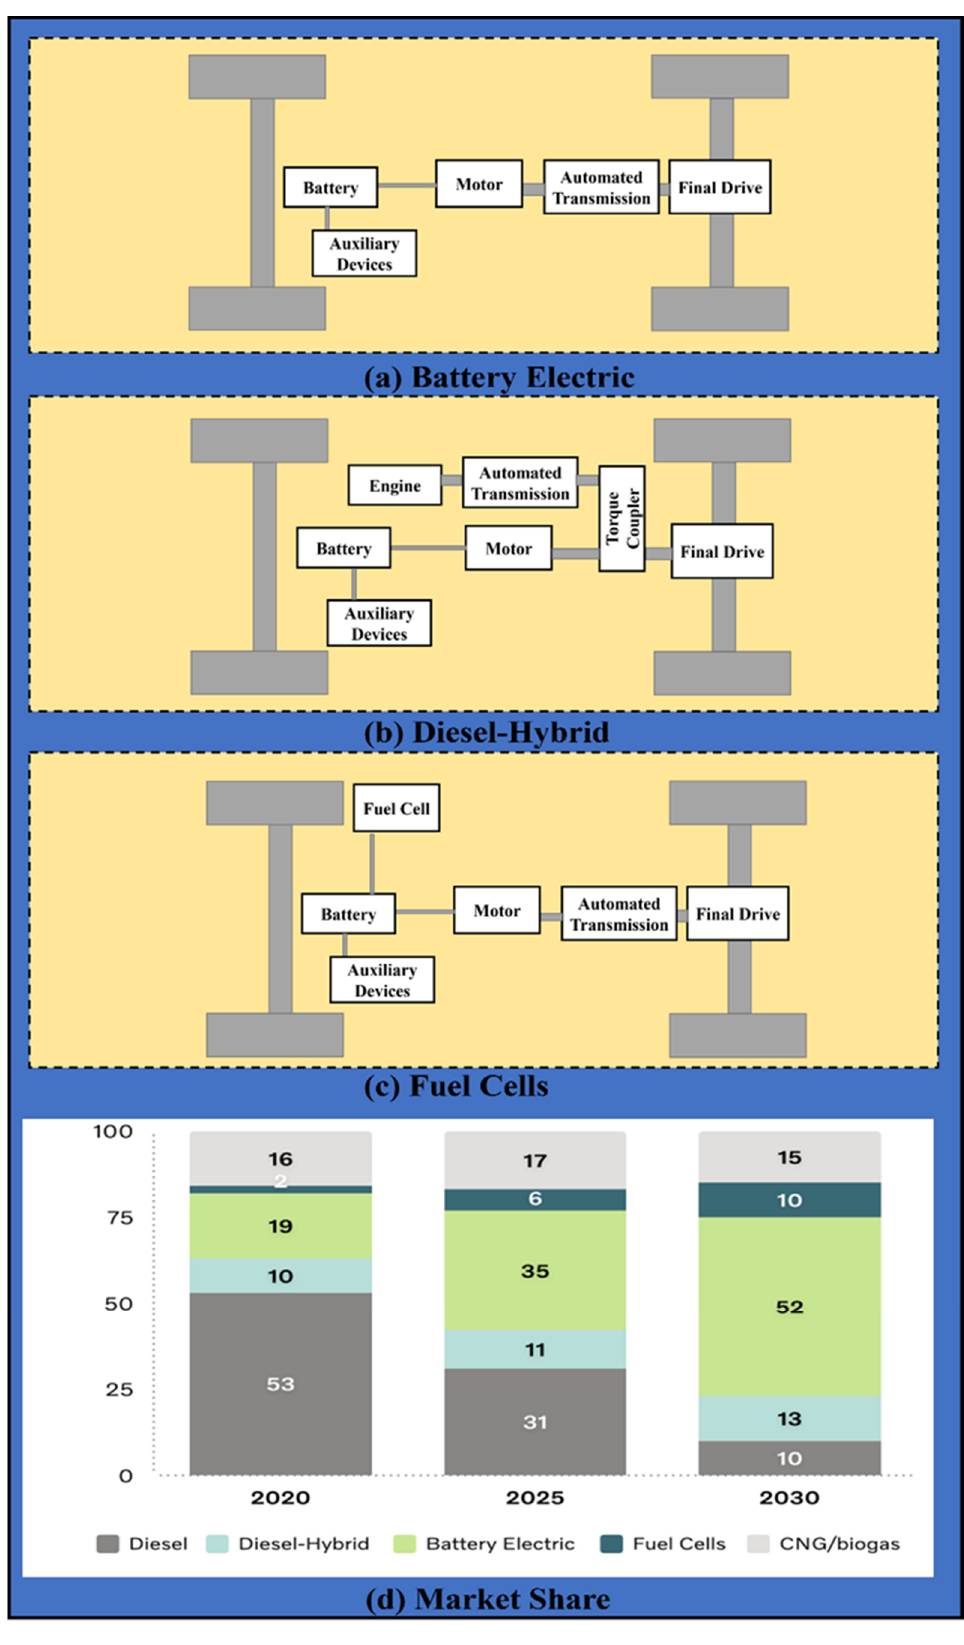
Figure 1. Global electric buses’ market share according to the bus type (2020–2030): ( a ) BEB, ( b ) series hybrid electric bus (HEB), ( c ) parallel HEB and ( d ) Market Share [11].